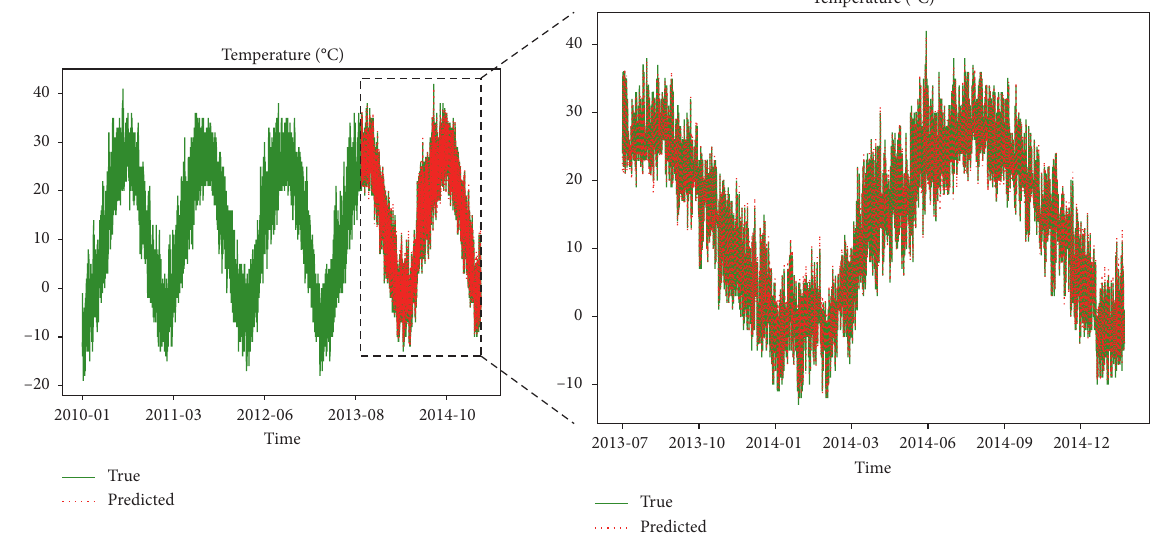
Figure 11: Temperature prediction with TL from PM2.5 Table 2: RMSEs of prediction. Prediction task